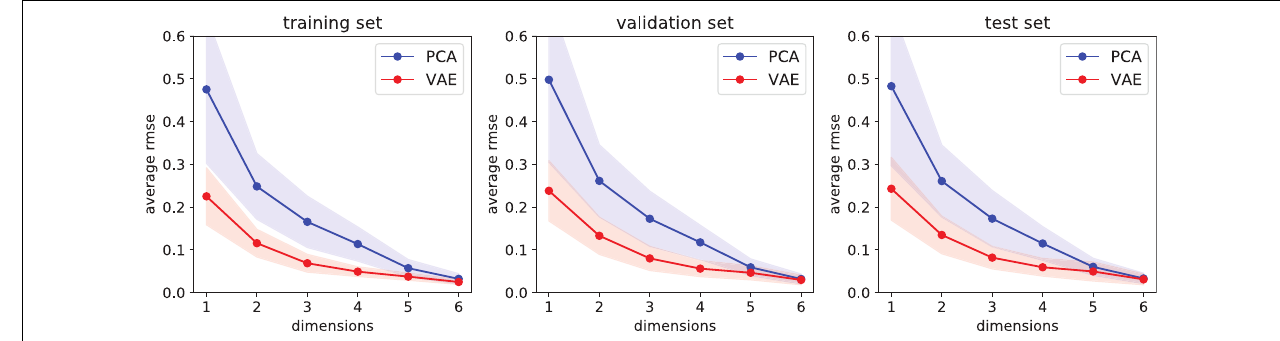
FIGURE 9 | Reconstruction error as a function of feature dimension. Results show the average error plus-minus one standard deviation for 1000 samples in each of the three sets: training (left) , validation (center) , and test (right) . The variational autoencoder (VAE) performs better than principal component analysis (PCA) since its reconstruction error has a smaller mean and variance. Reconstruction errors are similar for the three sets, suggesting a good